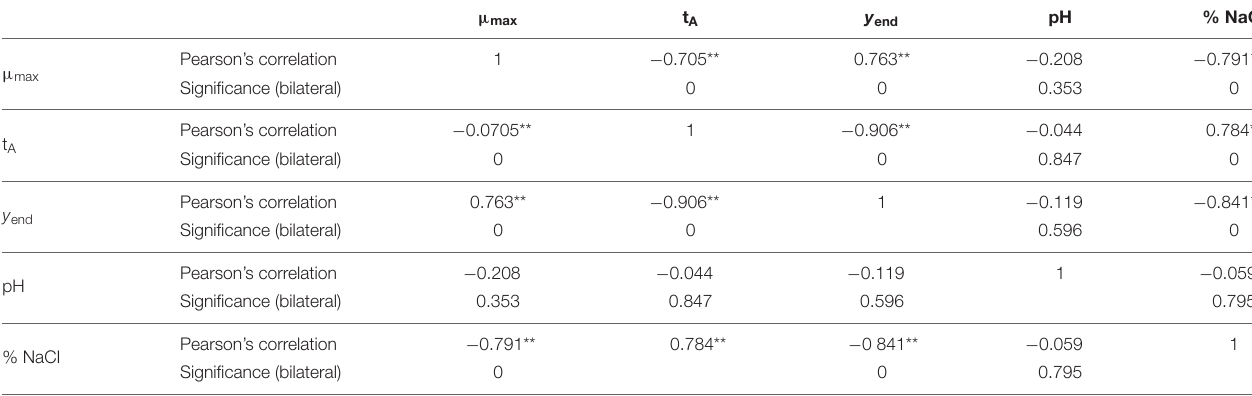
TABLE 4 | Correlations between the kinetic parameters of Vibrio spp. as a function of pH and%